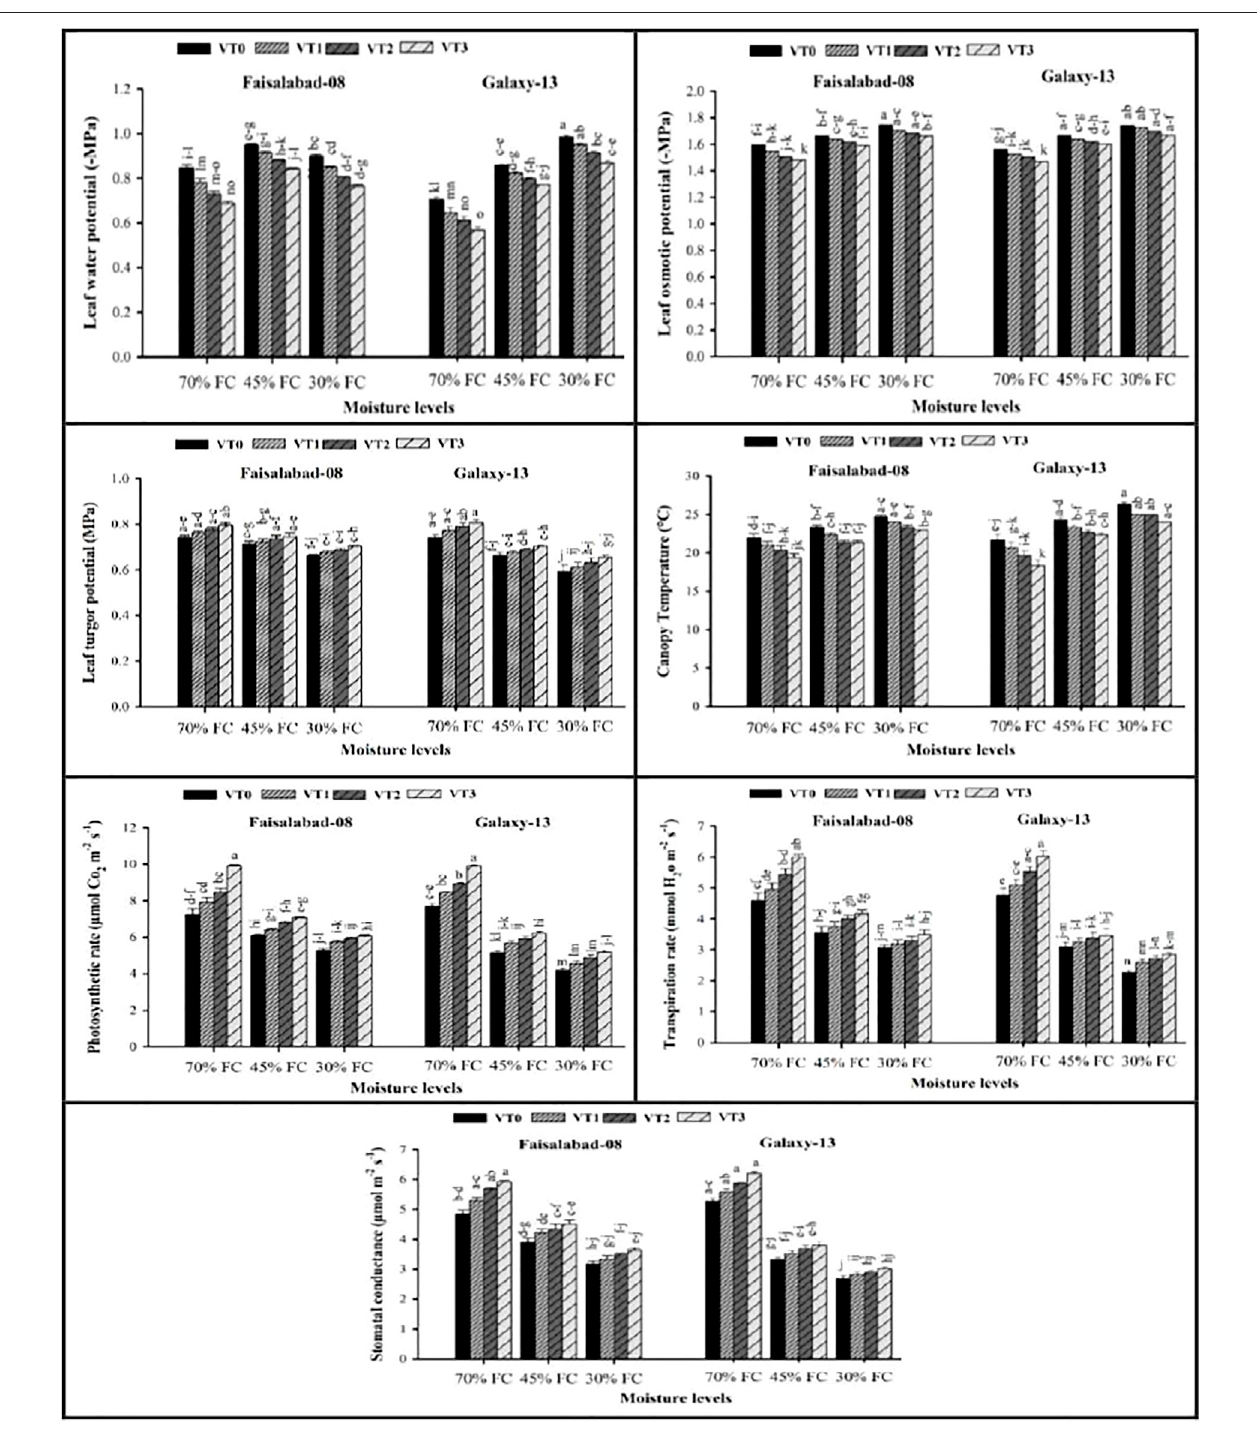
FIGURE 3 | Effect of soil-applied wheat straw vermicompost (VT) on leaf water potential, leaf osmotic potential, leaf turgor potential, canopy temperature, photosynthetic rate, transpiration rate, and stomatal conductance of two wheat cultivars under different drought levels [70% fi eld capacity (FC), 45% FC, and 30% FC]. Bars with different alphabetical letters differ signi fi cantly at 5% probability, according to Tukey ’ s HSD test. VT 0 , control; VT 1 , 4 t ha − 1 ; VT 2 , 6 t ha − 1 ; and VT 3 , 8 t ha − 1 .